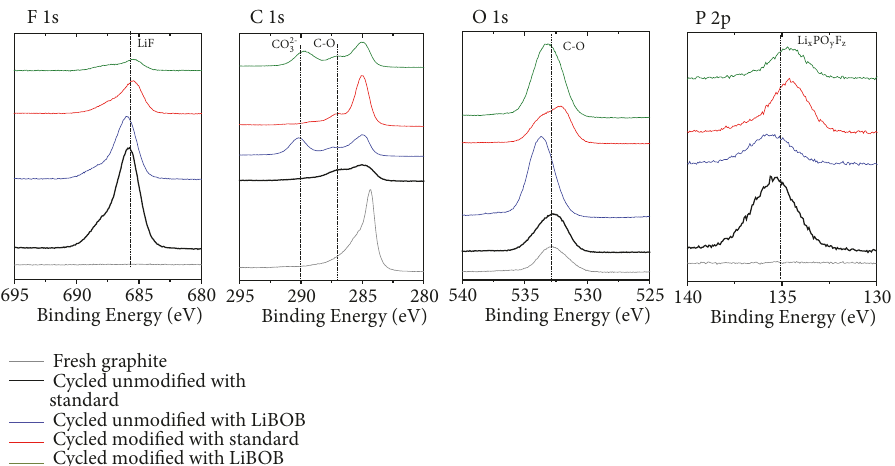
Figure 3: XPS surface analysis of fresh and cycled graphite in PA modified and unmodified LNMO electrodes in graphite full cells with and without LiBOB in the